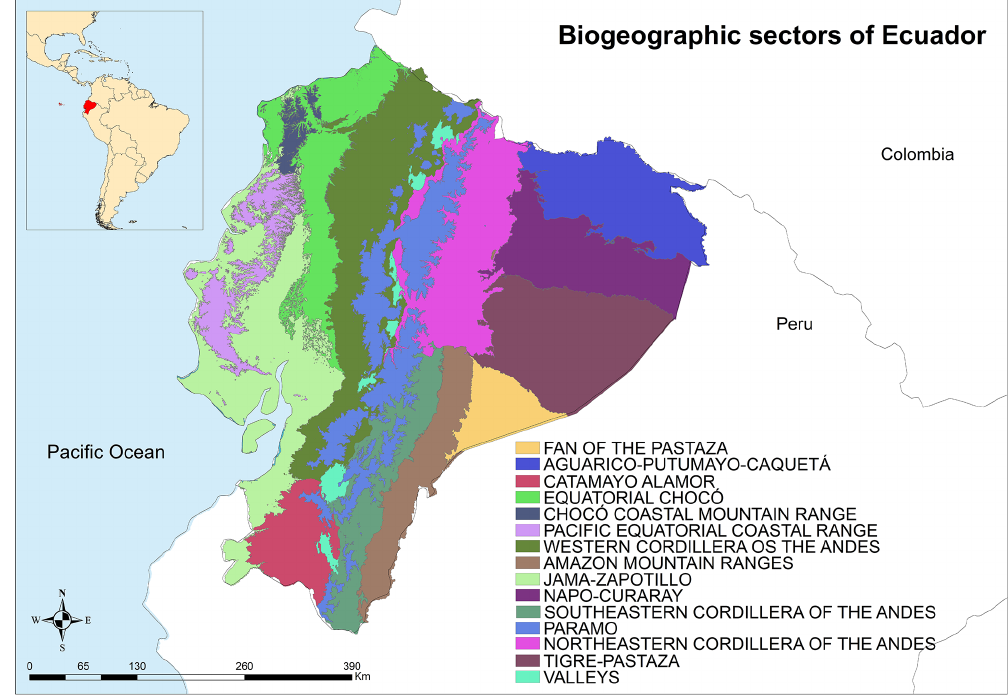
Figure 4. Map of the biogeographic sectors of Ecuador, extracted from the “Sistema de clasificación de Ecosistemas del Ecuador Continen- tal” (Ministerio de Ambiente del Ecuador,